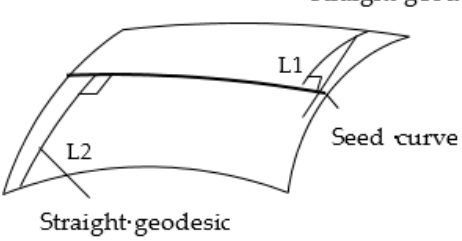
Figure 7. Surface Height Measurement Method.